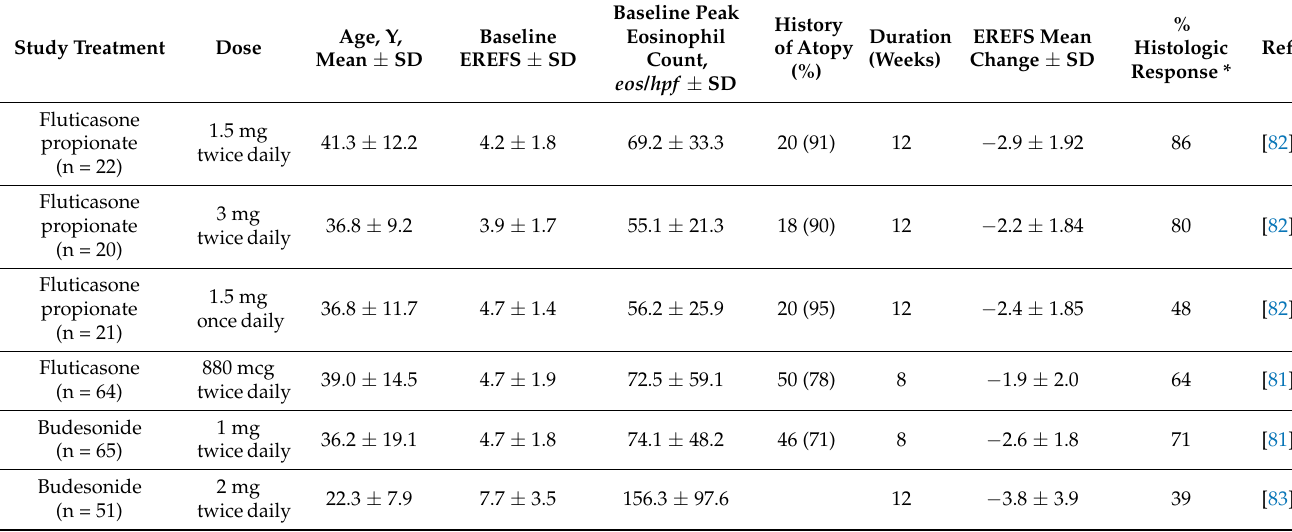
Table 2. The results of randomized trials on swallowed topical steroids